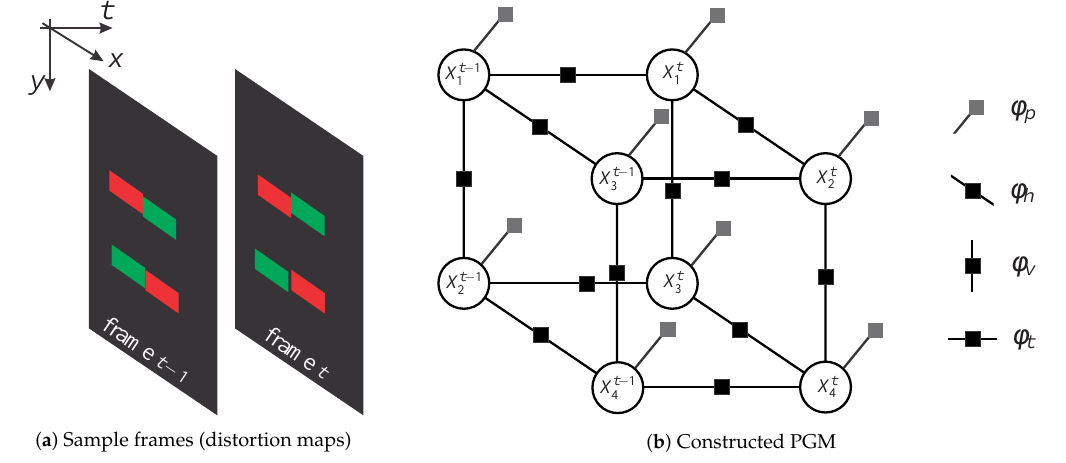
Illustration of the probabilistic graphical model (PGM)-based modeling procedure: ( a ) simplified distortion map; ( b ) corresponding